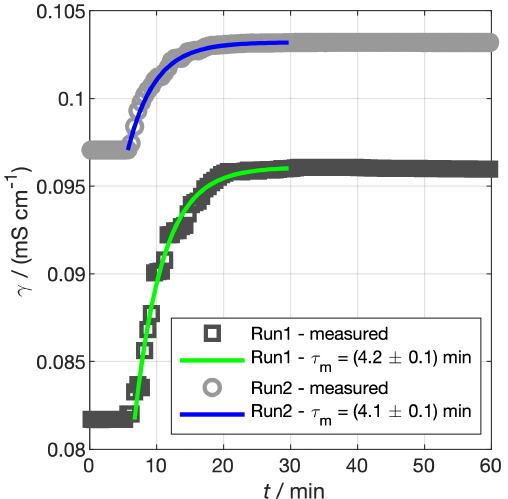
Figure 7. Experiments to determine the mixing time constant of our tank, τ m . Saturated NaCl solution was spiked into the tank and mixed under pumping. The conductivity of the bulk water is shown by the grey markers. The coloured lines show the prediction of Eq. (7) using τ m fit to the data. In reality, the spike in run 2 was a few hours after run 1, but the times for the two spikes have been matched for ease of comparison.